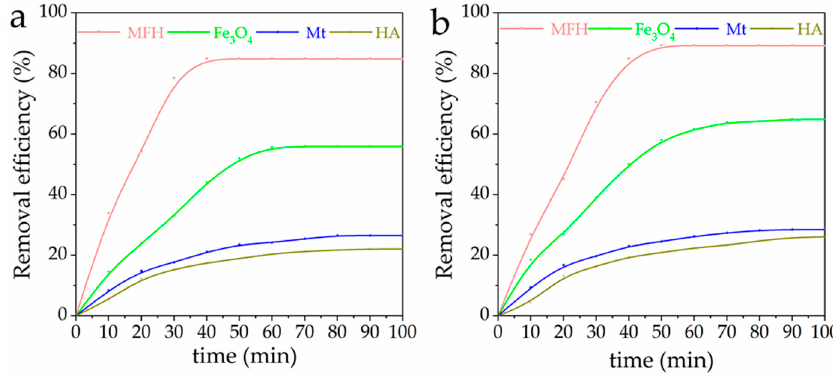
Figure 6. Simultaneously removing ( a ) Cr(VI) and ( b ) aniline using various adsorbents. ( c 0 (Cr(VI)) = 40.0 mg·L − 1 , c 0 (aniline) = 100.0 mg·L − 1 , c (adsorbent) = 0.1 g·L − 1 , T = 25 °C, pH = 3.0).